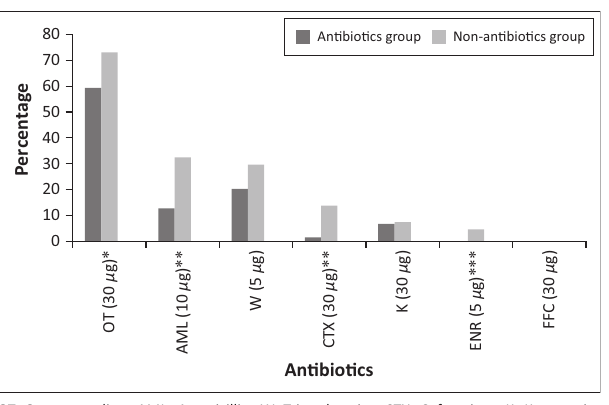
FIGURE 2: Frequency of isolation of virulence genes in percentages based on days of sampling.